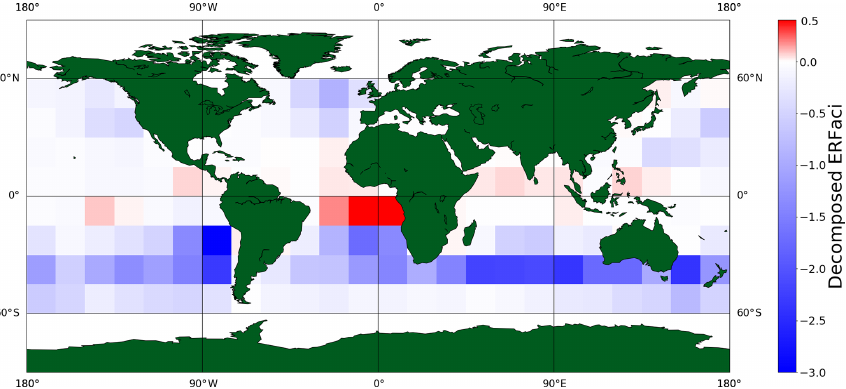
Figure 7. The ERFaci warm found as a sum of the RFaci warm and cloud adjustments (Fig. 6) with constraints on the LWP, EIS, and RH 700 on a regional basis ( − 0 . 26Wm − 2 ) without areal